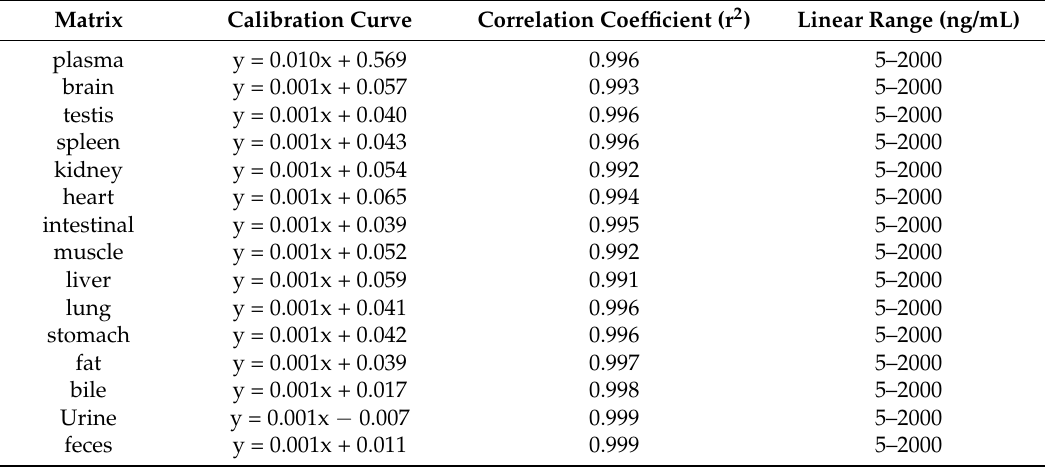
Table 3. Linearity and Linear range of ZGS2 calibration curves in different biological